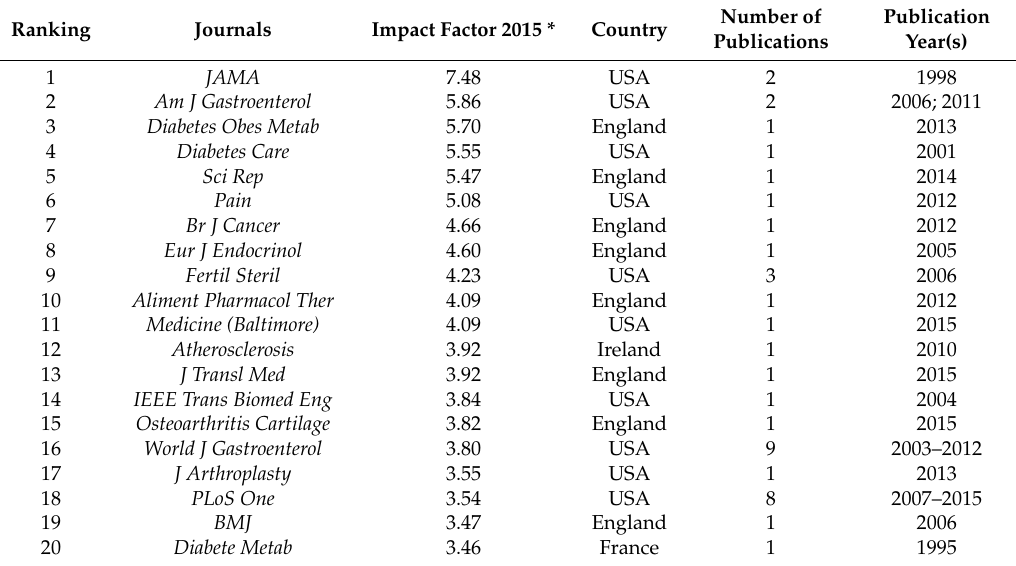
Table 3. Ranking of journals with TCM publications, based on the impact factor.